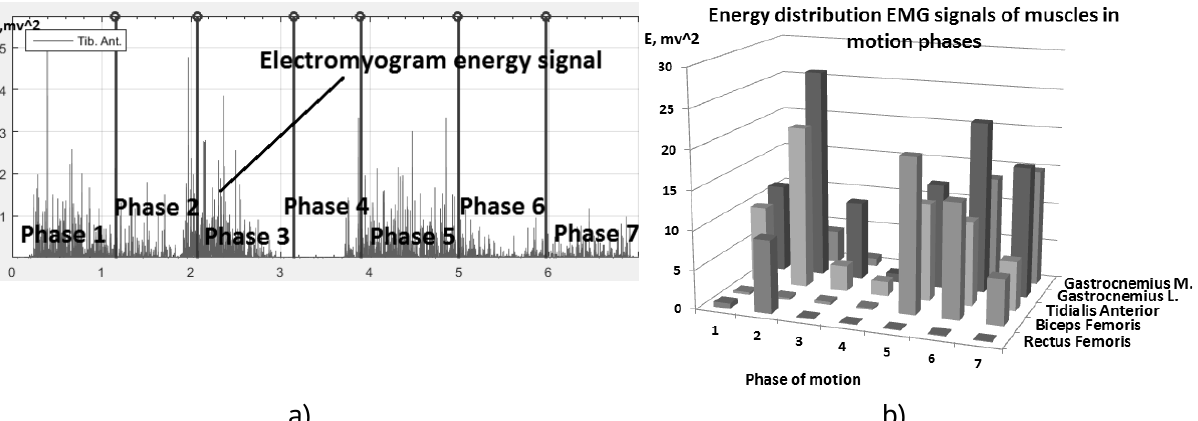
Figure 7. Amplitude-time analysis of EMG signals of muscles: a - EMG-signals' energy of the muscle Tibialis Anterior of the right leg when doing the motion test 1; b - the energy distribution of the EMG signals of the right leg's muscles in the phases of movement during the motion test